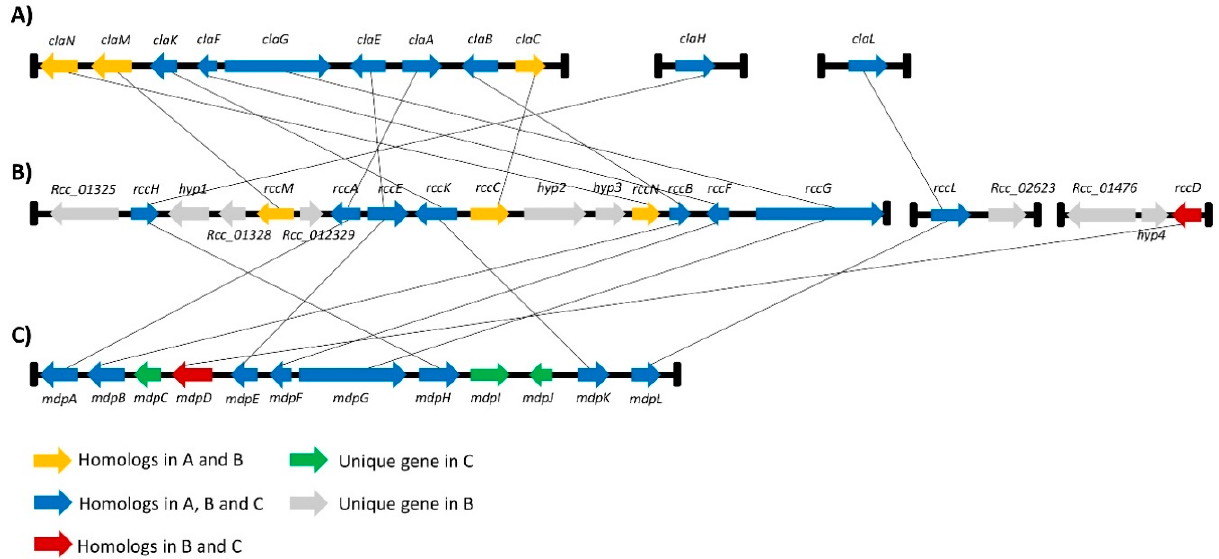
Figure 3. Homology between the rubellin candidate cluster and gene clusters involved in the biosynthesis of known secondary metabolites structurally related to rubellin; ( A ) The cladofulvin biosynthetic gene cluster in C. fulvum was described by Griffith et al.; ( B ) The rubellin candidate gene cluster in R. collo-cygni consists of gene clusters organised around the core gene rccG as well as two miniclusters named rccL - and rccD miniclusters organised around rccL and rccD , respectively; ( C ) The monodictyphenone biosynthetic gene cluster in A. nidulans was identified by Chiang et al. [42]. Homology was confirmed by reciprocal BLAST using the NCBI database.